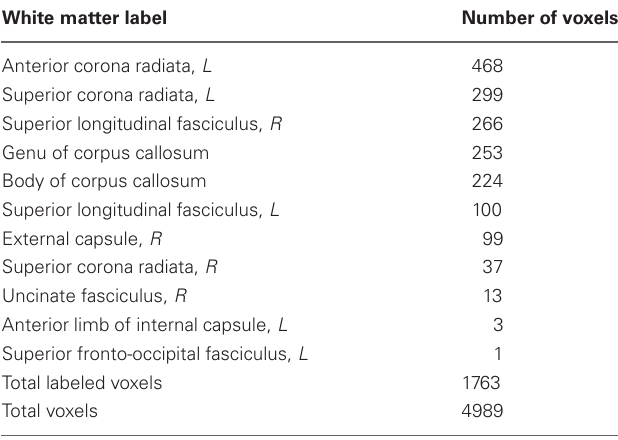
Table 3 | Locations of voxels showing MD